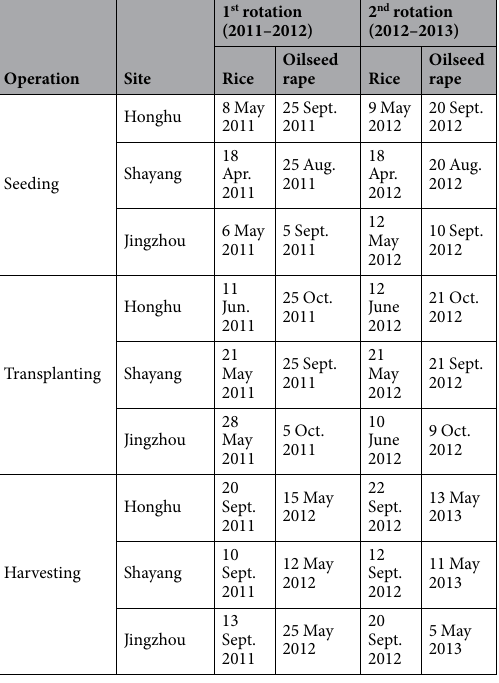
Table 5. Timing of each operation for rice and oilseed rape in study regions of Hubei province,